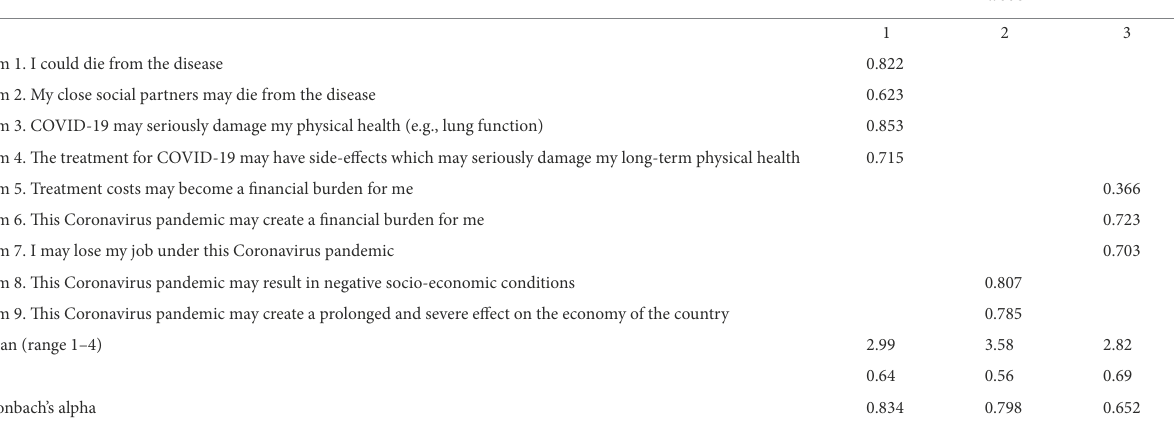
TABLE 2 Factor loadings of the observed variables in Promax rotation (pattern matrix), descriptive statistics, and reliability of factors ( N = 1955).